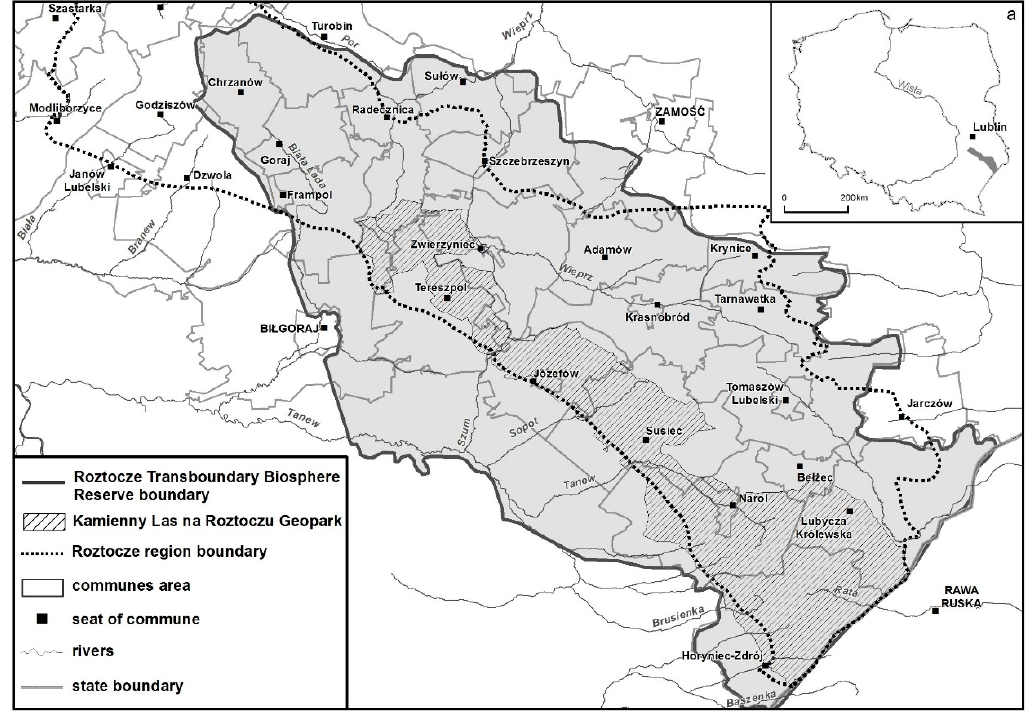
Figure 1. Location of the Polish part of the Roztocze Transboundary Biosphere Reserve [9,10] and the “Kamienny Las na Roztoczu” geopark project [29] against the border of the Roztocze region [8].